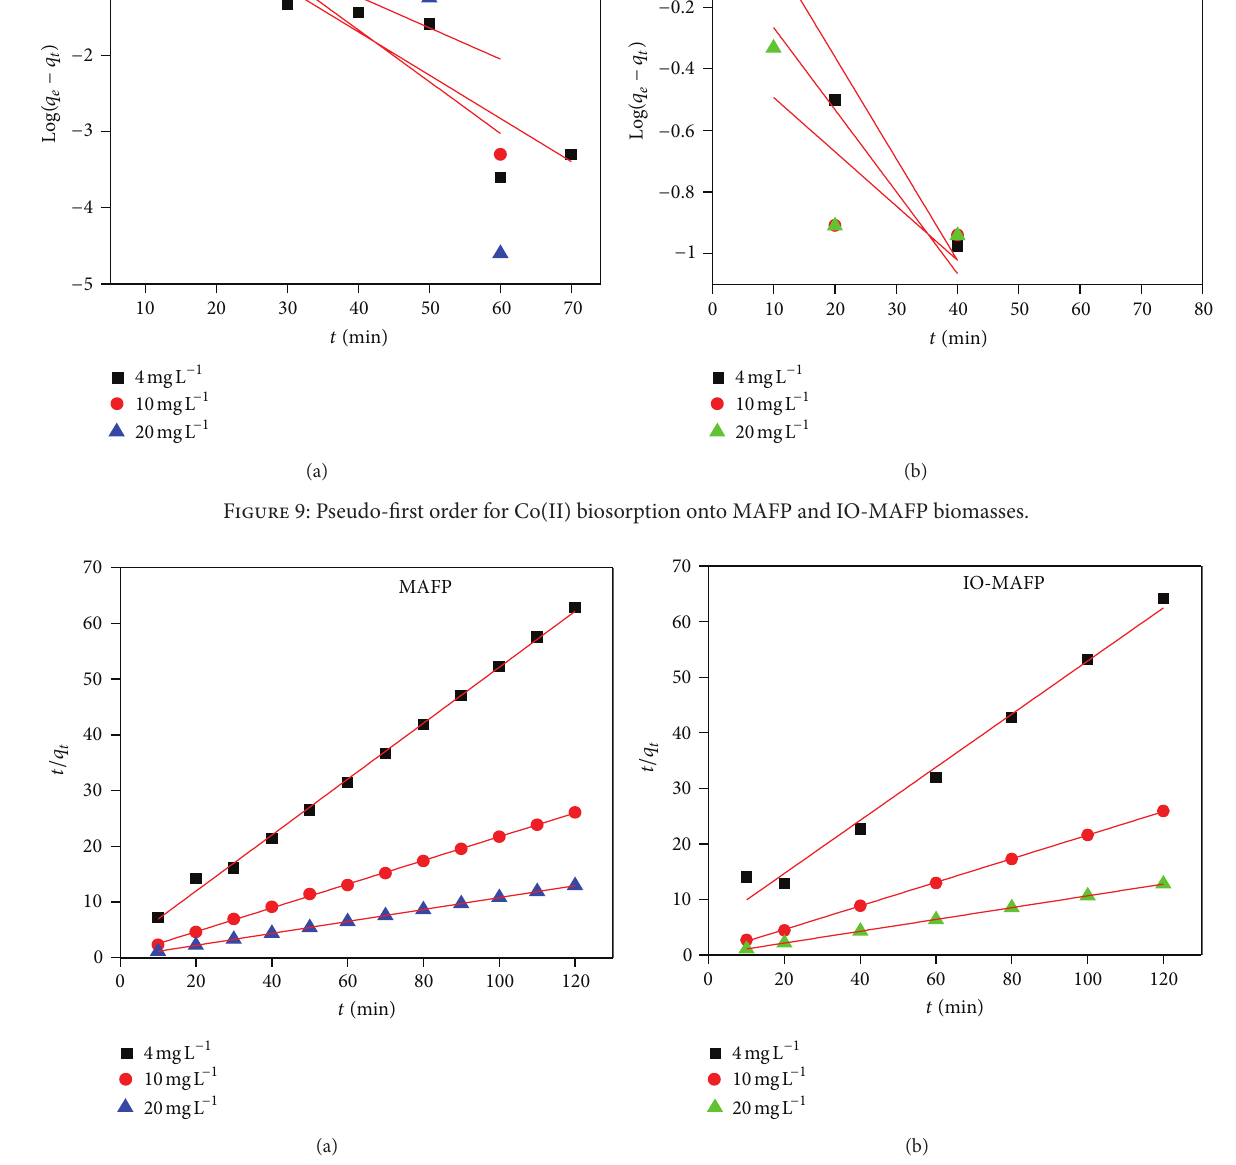
Figure 10: Pseudo-second order for Co(II) biosorption onto MAFP and IO-MAFP biomasses. Table 2: Kinetics parameters of Co(II) biosorption with MAFP and